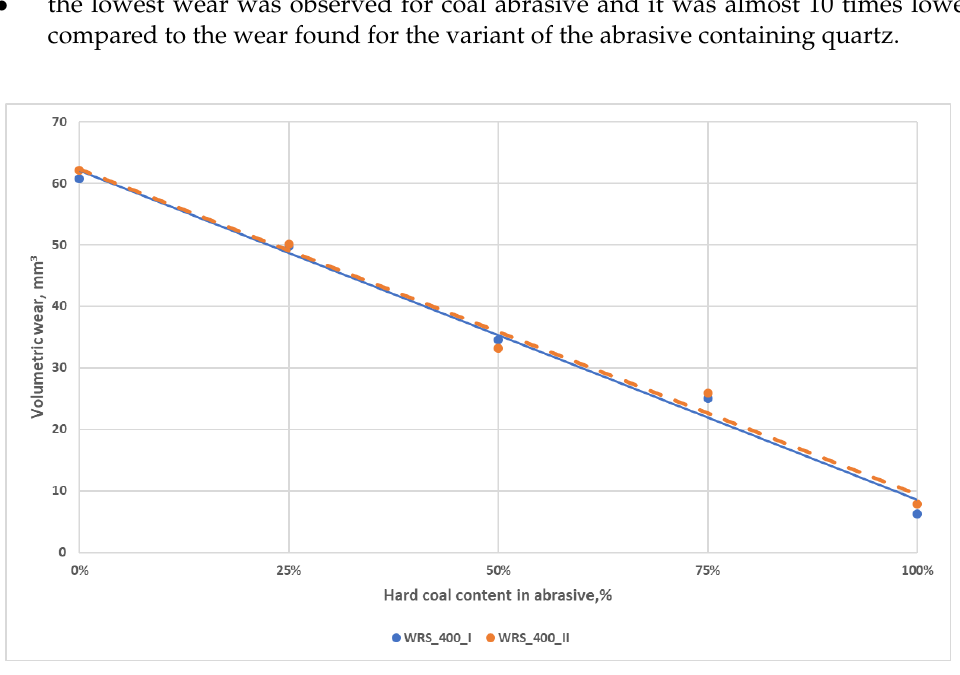
Figure 15. Time processes of volumetric wear u V of WRS_400_II steel for the discussed wear vari- ants.